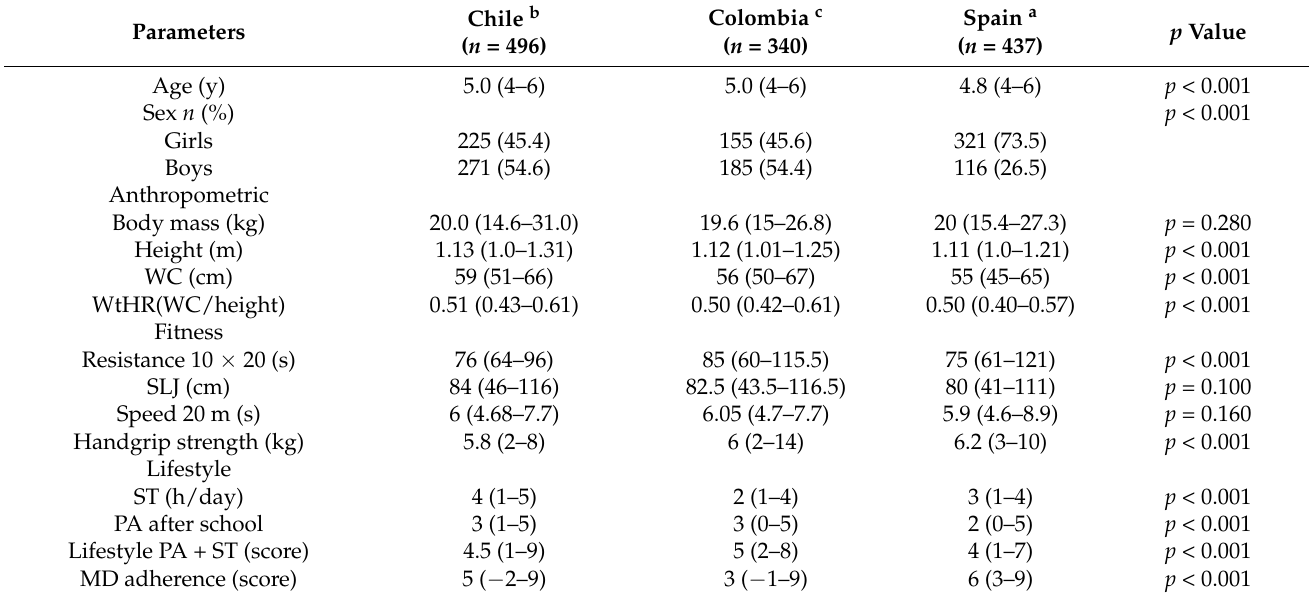
Table 1. Anthropometric characteristics, physical fitness, and nutritional status of the children according to their country.